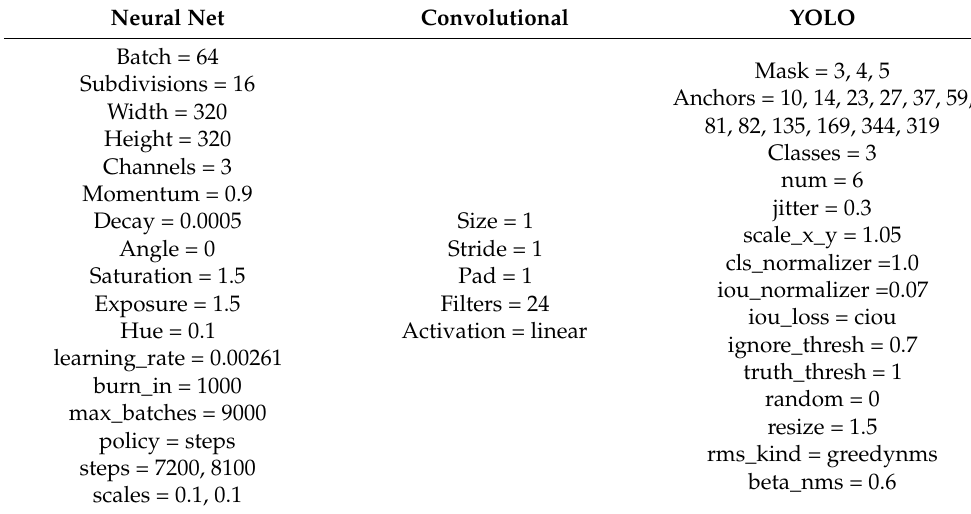
Figure 7. Data augmentation. The parameter configurations are presented in Table 3. Table 3. Parameter configuration.